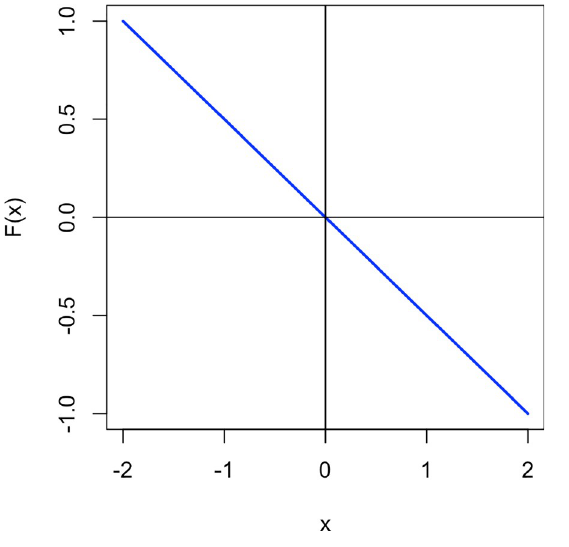
Fig 2. Graph of the function F(x) from